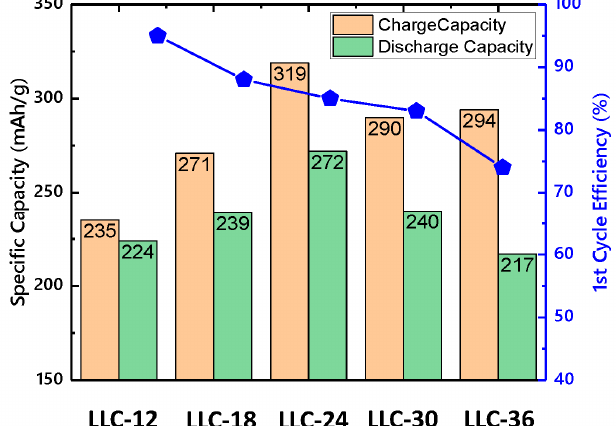
Figure 4. Specific capacity and 1st-cycle coulombic efficiency for LLCs electrode. As shown in Figure 5a, specific capacity vs. cycle number after 20 cycles, the dis- charge capacities for LLC − 12, LLC − 18, LLC − 24, LLC − 30 and LLC − 36 are 199, 181, 210, 208 and 187 mAh/g, respectively. Figure 5b shows the average discharge voltage profiles as a function of the cycle numbers. Clearly, the average discharge voltage increases with the